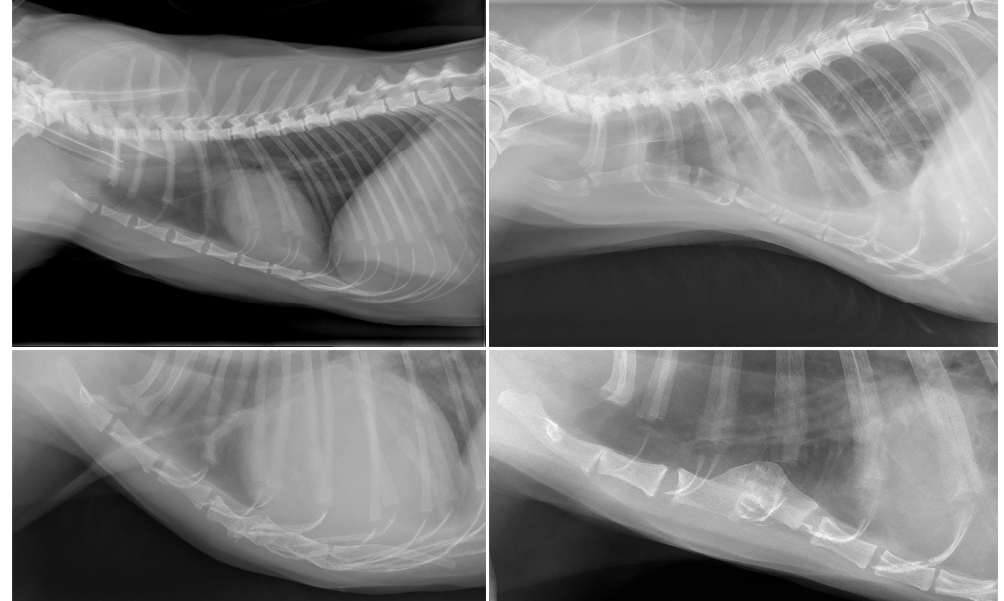
Figure 3. ( Top left ) panel: Example of a left lateral radiograph of a cat with a sternum that was considered normal. ( Bottom left ): Abnormal low number of sternebrae in a 12-year-old female Domestic Shorthair. A total of six individual sternebrae are present, caused by fusion of the fifth and sixth sternebrae and an absence of the seventh sternebra. ( Top right ): Pectus excavatum in an 11-year-old female neutered Domestic Shorthair. ( Bottom right ): Chronic subluxation of the fourth sternebra in an 11-year-old male neutered Domestic Shorthair. The fourth sternebra is displaced dorsally and fused with the third sternebra.